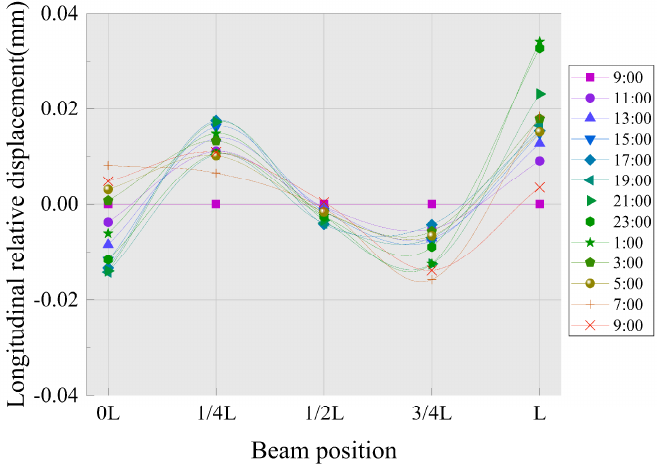
Figure 11. Displacement between the base plate and beam body.